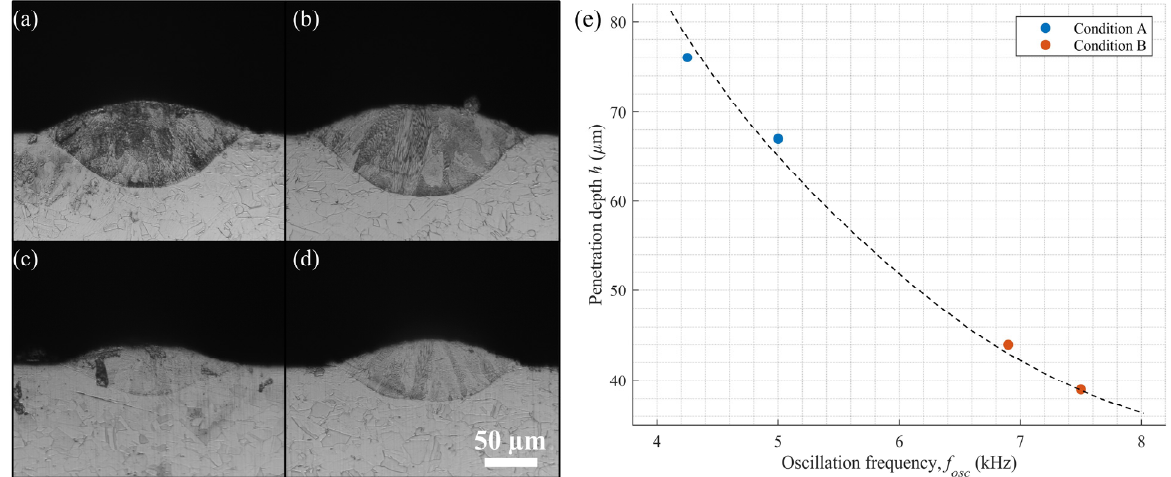
Figure 11. Metallographic cross-sections of the two samples: ( a ) Condition A, replicate 1, ( b ) Condi- tion A, replicate 2; ( c ) Condition B, replicate 1; ( d ) Condition B, replicate 2; and ( e ) penetration depth h against oscillation frequency, f osc